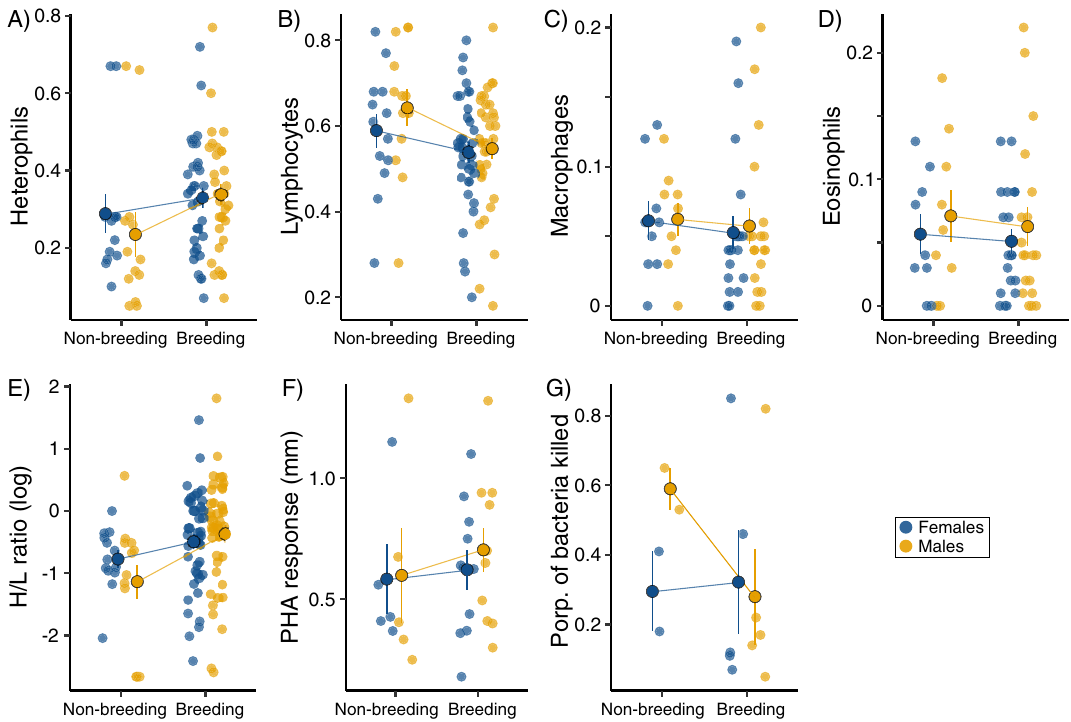
Figure 2. Characteristics of the immune system in wild birds. White blood cells ( A – D , expressed as the proportion of the total white blood cell count), heterophils/lymphocytes (H/L) ratio ( E ), phytohaemagglutinin response ( F ), and bacteria-killing ability ( G ) in breeding and non-breeding birds (blue and yellow dots refer to females and males, respectively). Large outlined dots and whiskers are arithmetic means and standard errors,